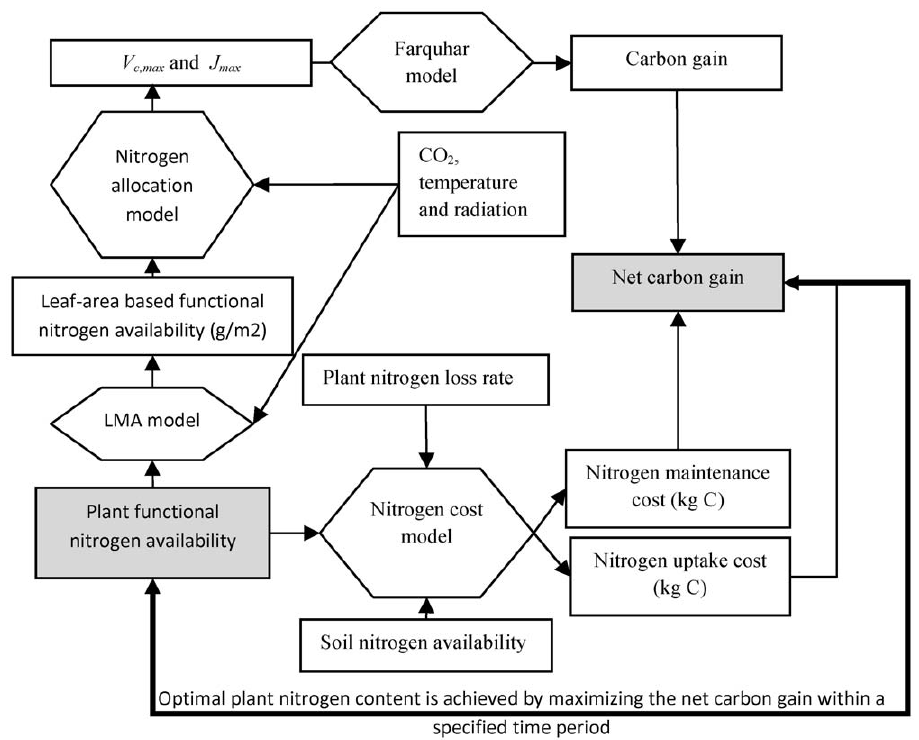
Figure 8. Plant functional nitrogen availability optimization by linking a nitrogen allocation model and a nitrogen cost model. The rectangles represent state variables of interests. The shaded ones represent the target variables to achieve optimization/maximization. The hexagons represent models. Optimal plant functional nitrogen availability is achieved by maximizing the net carbon gain within a specified time period. The net carbon gain is based on the net carbon balance between photosynthesis and carbon cost of plant nitrogen maintenance and uptake. Nitrogen allocation model is used to predict the photosynthesis parameters ( V c,max and J max ) for the Farquhar photosynthesis model.